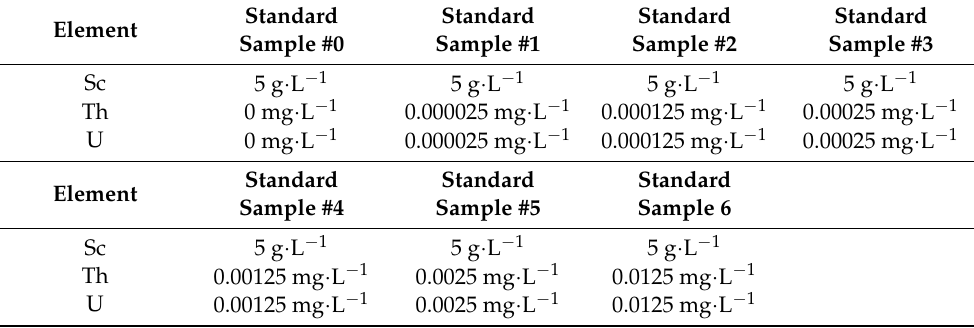
Table 2. Standard series solution and